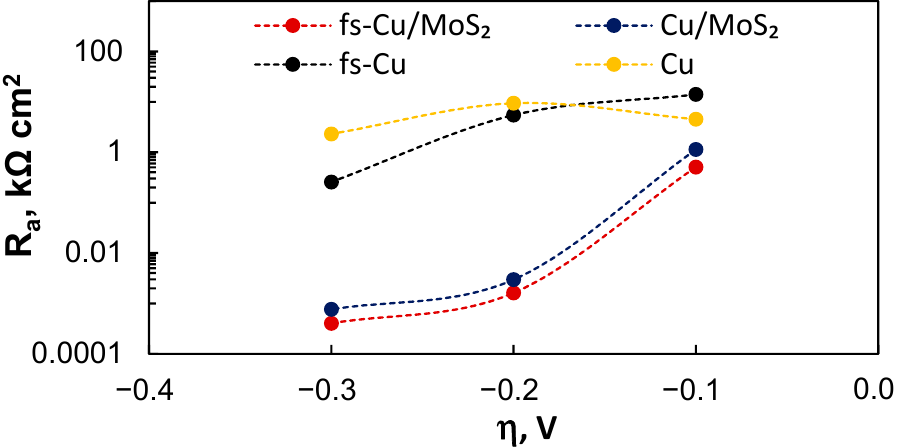
Figure 11. The equivalent circuit fitting results: the values of R a in relation to the overpotential.